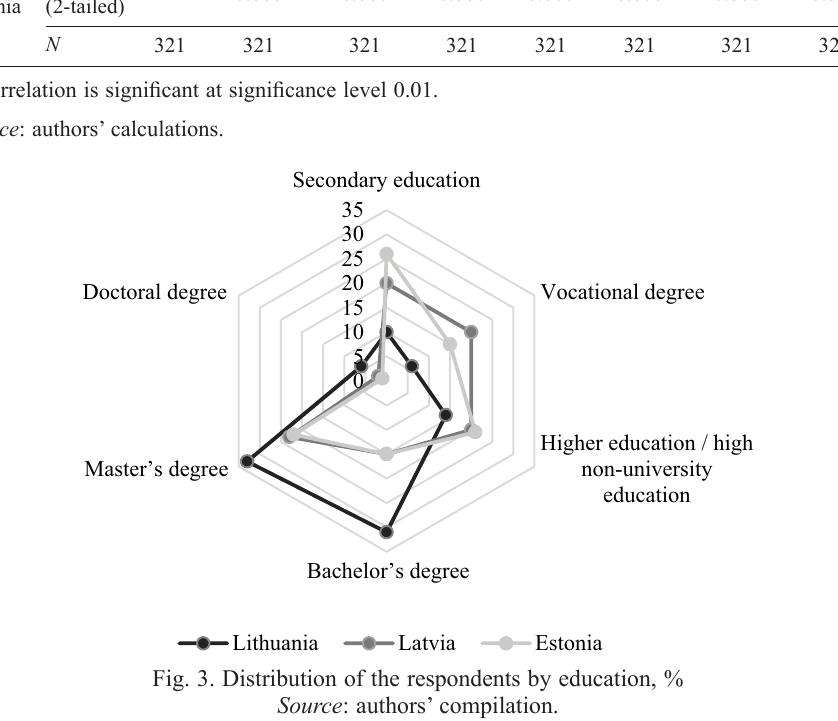
Fig. 3. Distribution of the respondents by education, % Source : authors’ compilation.